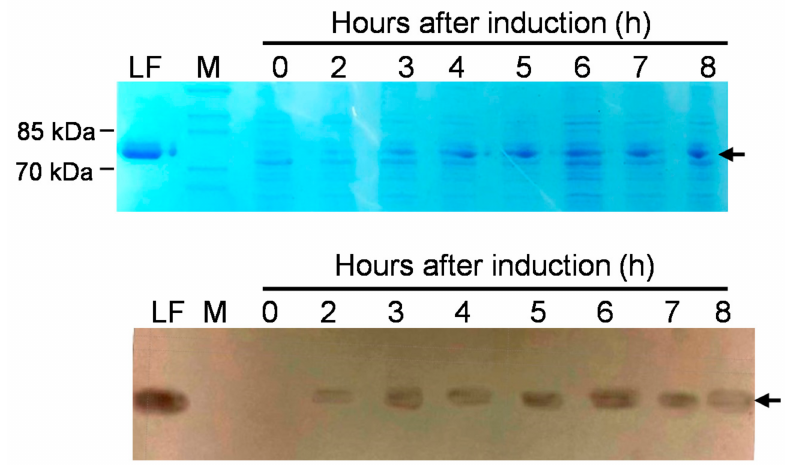
Figure 5. The time course of LF expression in the transformed Lactobacillus gasseri /BLF. BLF expres- sion in L. gasseri /BLF cells was induced using 1 ng/mL nisin for 0, 2, 3, 4, 5, 6, 7, and 8 h. The cell lysates were harvested and subjected to SDS-PAGE analysis (top panel) and Western blotting analysis (bottom panel). Lane LF: control panel of 0.32 µ g purified bovine lactoferrin (80 kDa); M: molecular weight marker; arrow indicates target lactoferrin with a molecular weight of about 80 kDa.